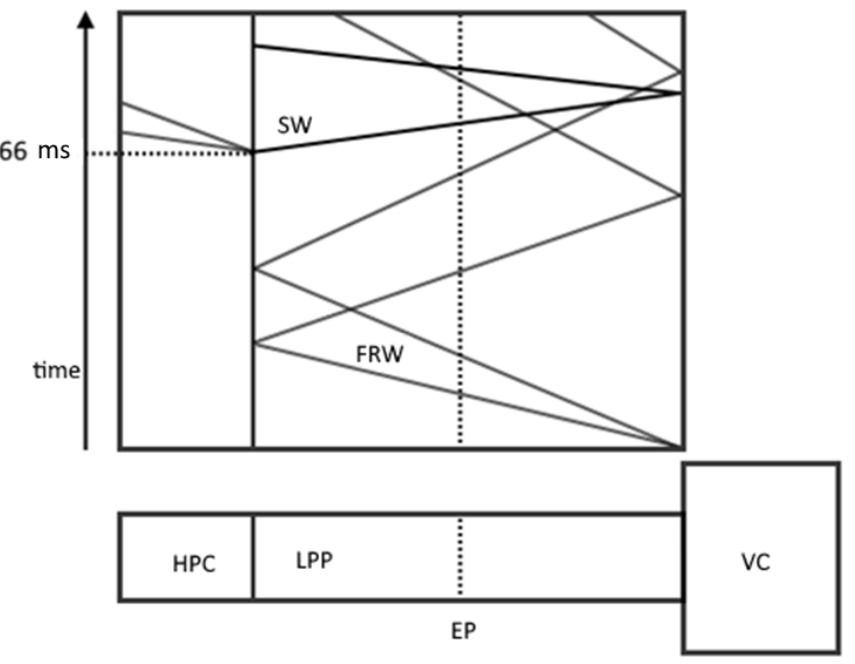
Figure 6. Schematic representation of the experimental setup and x-t diagram of the process. FRW is a fan of rarefaction waves; SW is a shock wave.